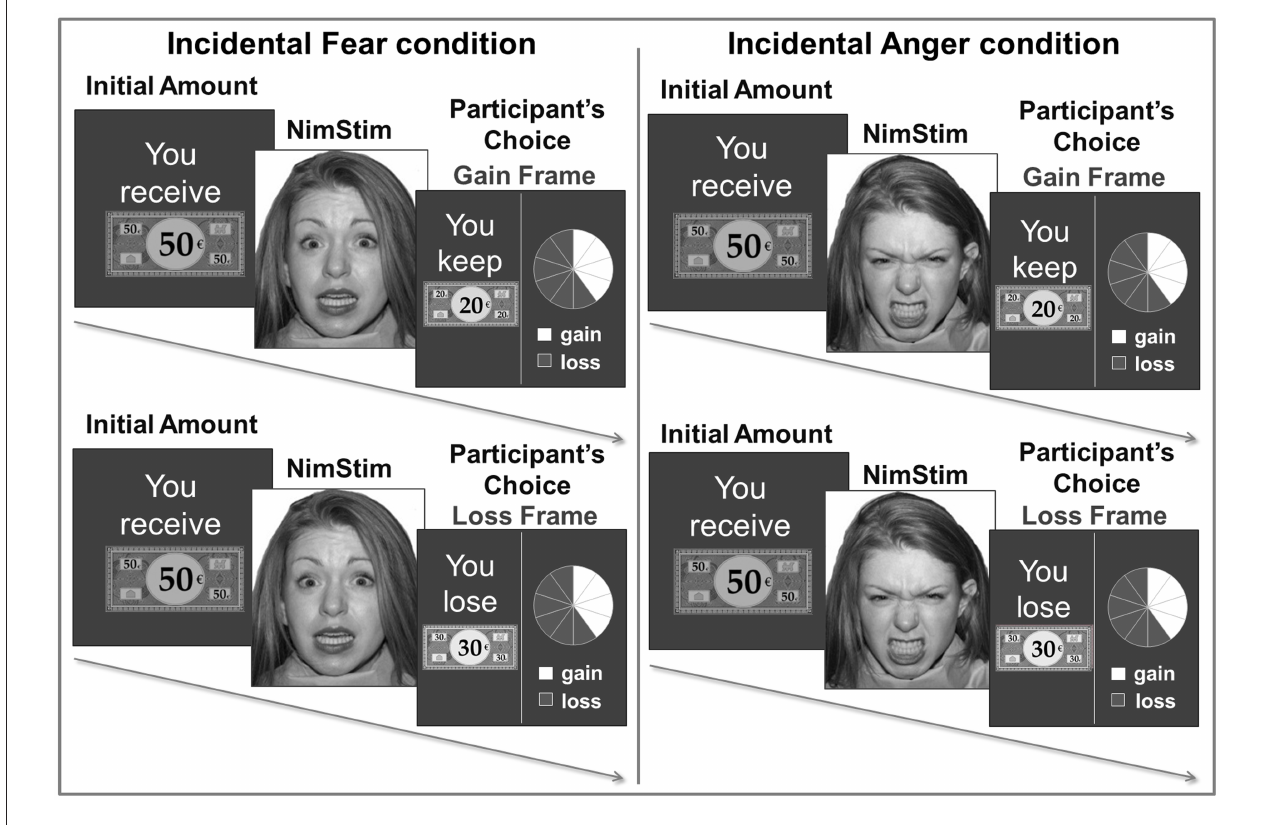
2009) was then presented: a fearful face in the incidental fear condition and an angry face in the incidental anger condition. Finally, the participants chose between a sure and a gamble option of equally expected value in a gain frame or in a loss